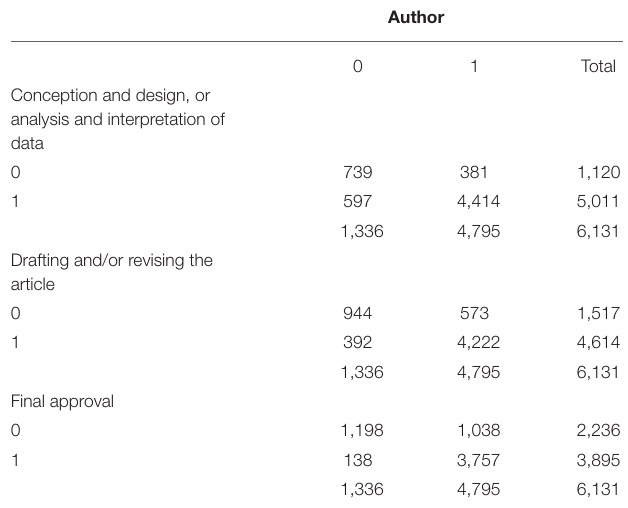
TABLE 1 | Number of authors and fulfillment of vancouver